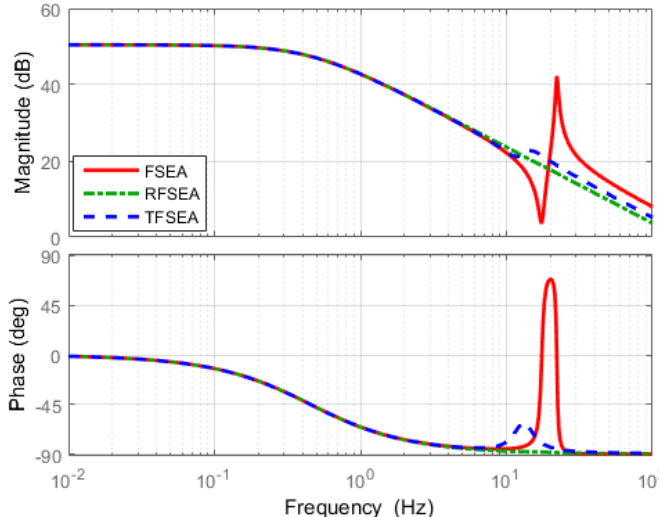
Figure 20. Frequency Response Functions (FRFs) of